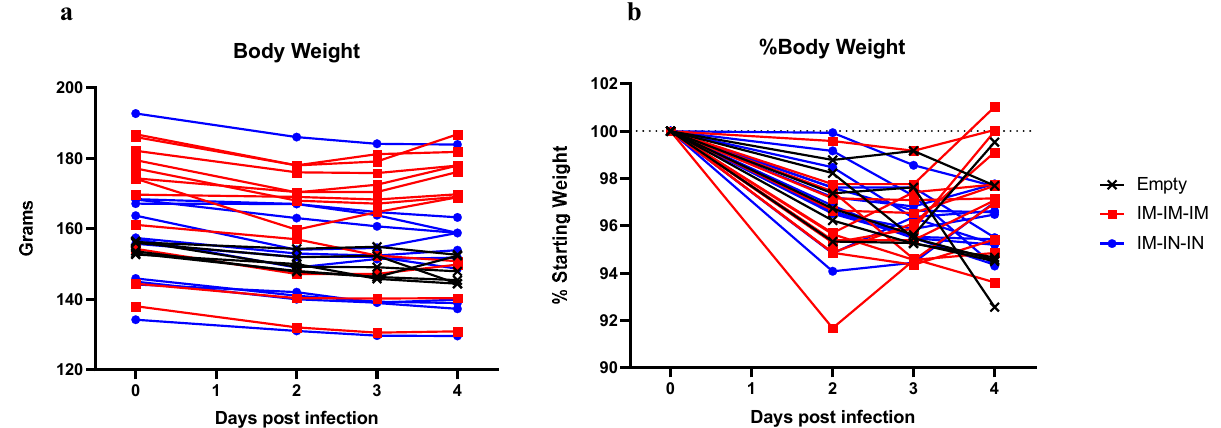
Figure A3. Prime Boost-Boost Hamsters Detailed Body Weights. Prime-Boost-Boost hamsters were divided into two spike-vaccinated groups receiving IM-IM-IM or IM-IN-IN vaccinations of 50 µ g Sp_pVax1 DNA plasmid complexed to in vivo delivery reagent. n = 12 per group. Detailed body weight over course of infection for individual hamsters is shown as ( a ) exact body weight in grams or ( b ) percent body weight.